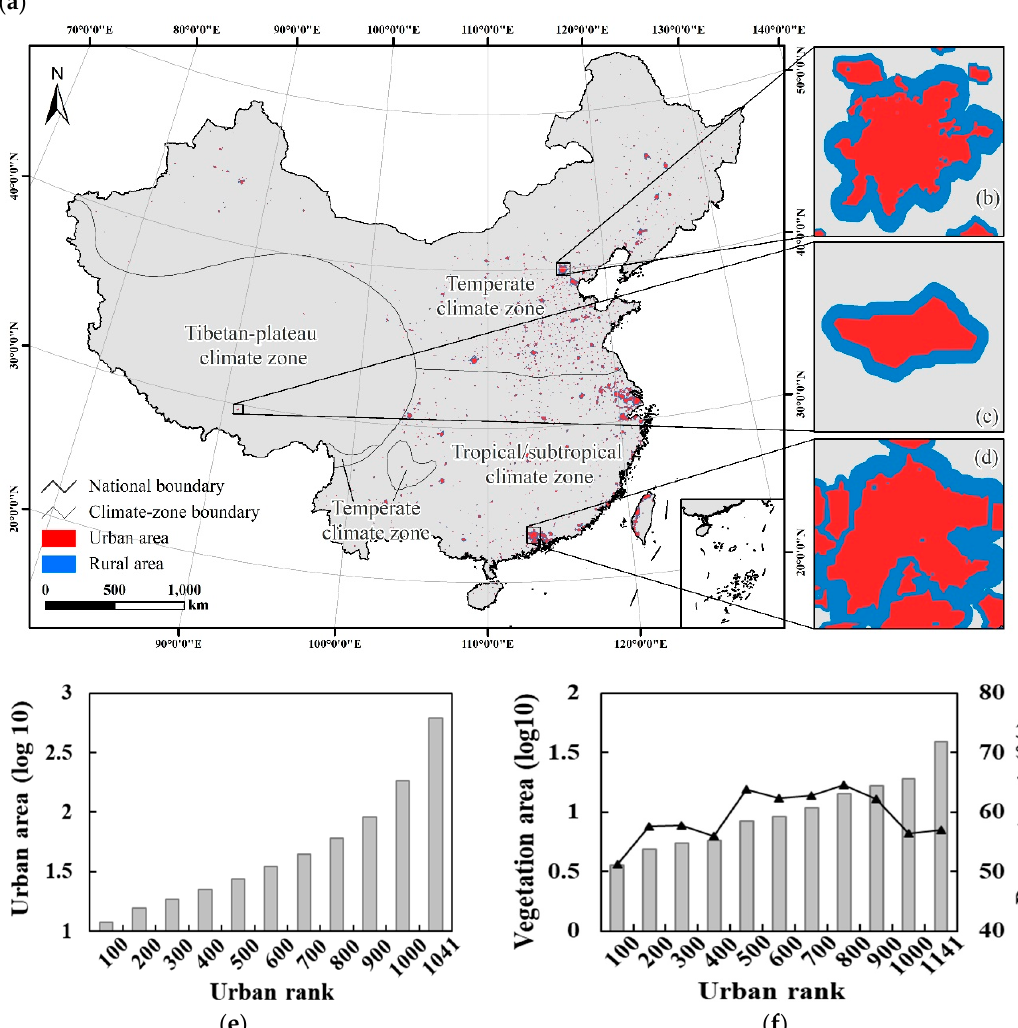
Figure 1. Urban clusters and rural buffers in ( a ) China and the three enlarged examples in ( b ) Beijing; ( c ) Lhasa, and ( d ) Guangzhou, which illustrate the extent of the urban clusters; ( e ) The average size of the urban area in each bin; ( f ) The average size of the vegetation area in each bin. The percentage is the proportion of the number of vegetation pixels to the total number of pixels in each bin. The unit of area is km 2 .